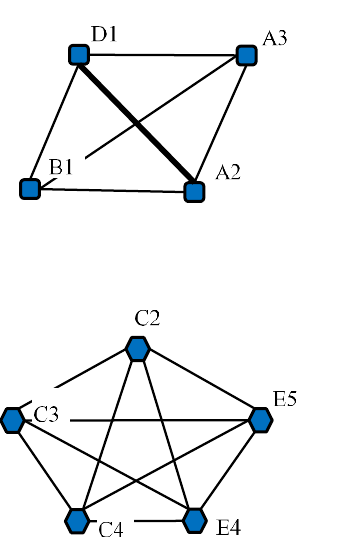
Figure 4. The classification and composition of ERC cohesive subgroups.